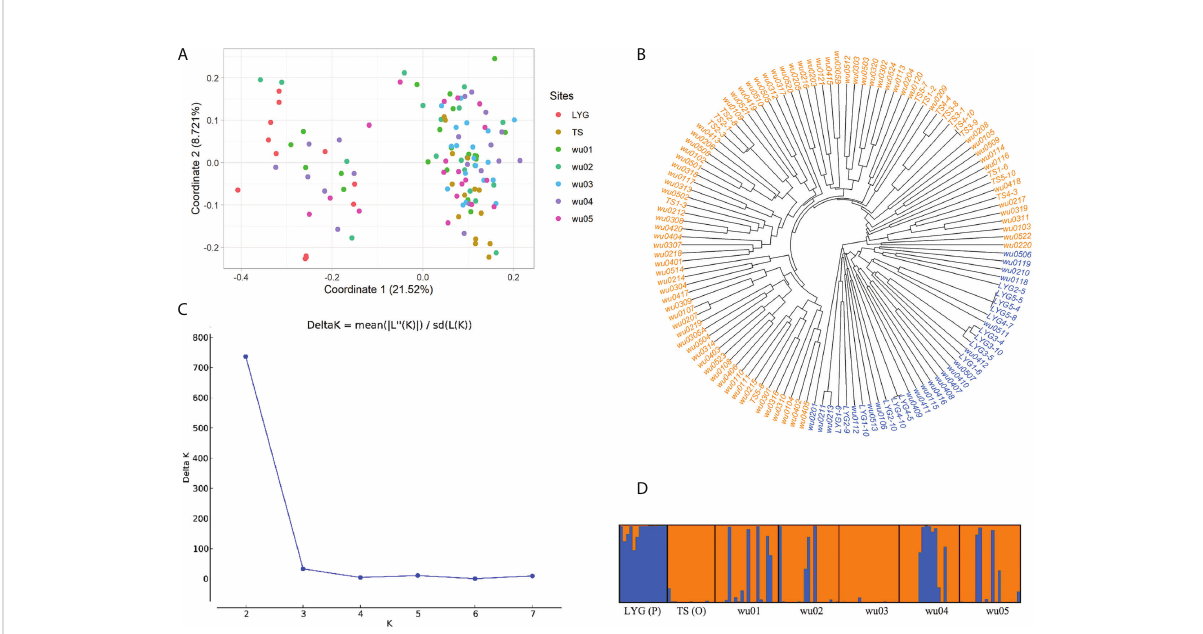
FIGURE 5 Microsatellite-based genetic structure of Phragmites australis populations in the Yellow River Delta, Lianyungang (LYG, lineage P), and Tangshan (TS, lineage O). (A) Principal coordinate analysis. (B) UPGMA clustering. Blue indicates lineage P, and orange indicates lineage O. (C) D K-value at different K. (D) STRUCTURE plot at K = 2. A thin line depicts each individual, and its color depends on its partitioning into the K clusters.